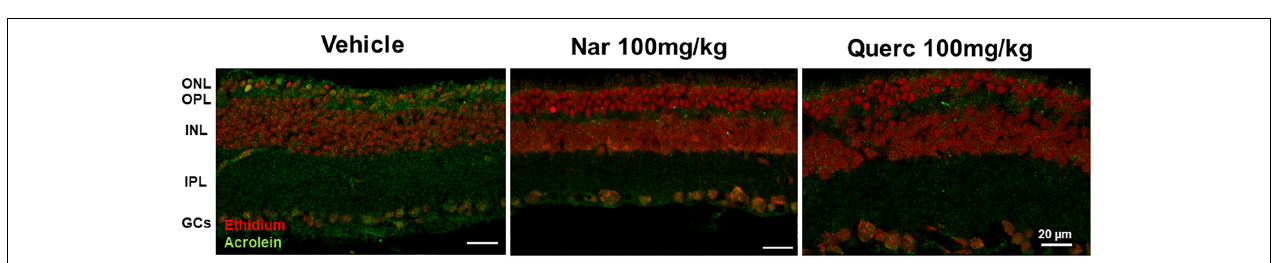
FIGURE 4 | Chronic treatment with naringenin and quercetin significantly reduces the expression levels of anti-oxidant enzymes. (A,C) Relative intensity of Sod1 and Sod2 immunoreactive bands quantified by densitometry scanning, respectively ( n = 3 for wt C57Bl/6J mice and n = 5 for each treatment group). Asterisks indicate significance ( ∗ p ≤ 0.05; ∗∗ p ≤ 0.01) by one-way ANOVA with Bonferroni’s multiple comparison test. (B,D) Representative immunoblots of Sod1 and Sod2, respectively.